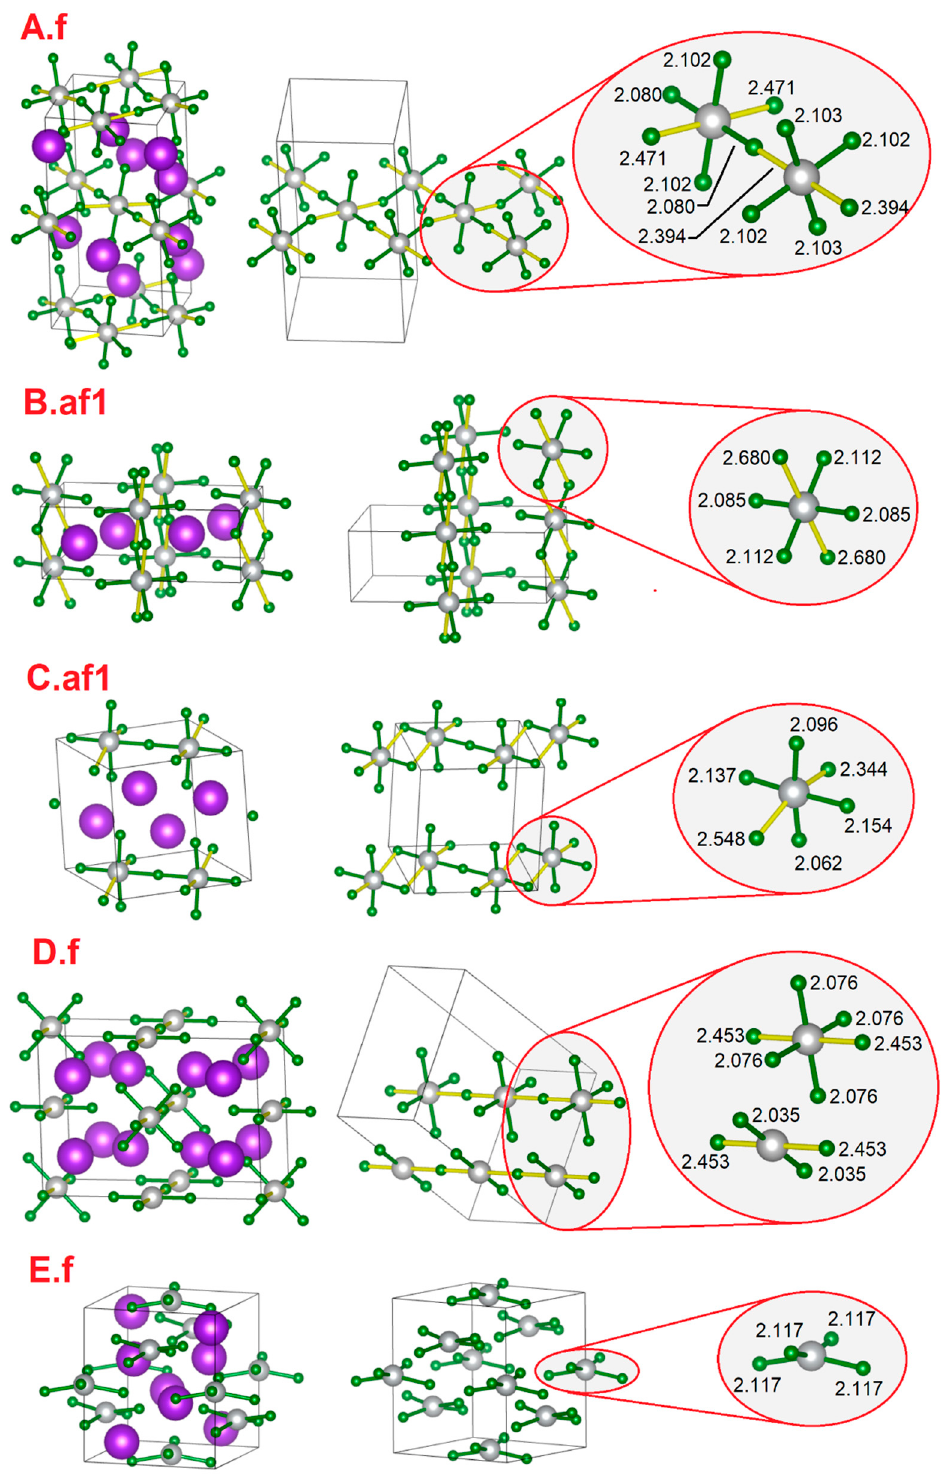
Figure 1. Crystal structures of five important polymorphs of K 2 AgF 4 derived from DFT computations (all at 0 GPa). Color code: gray = Ag, green = F, purple = K. Green lines indicate the presence of Ag-F bonds shorter than or equal to 2.2 Å, whereas yellow lines show Ag-F distances between 2.2 and 2.8 Å. Only AgF 4 sublattice is shown in the right panel, with potassium atoms removed for clarity. Structure labelling corresponds to that from Table 1. Indexes f or af1 stand for types of magnetic ordering. E.g., af1 for the B structure indicates that among the several computed models of the antiferromagnetic ordering of spins the one noted af1 (cf. Supplementary Materials) has the lowest enthalpy.